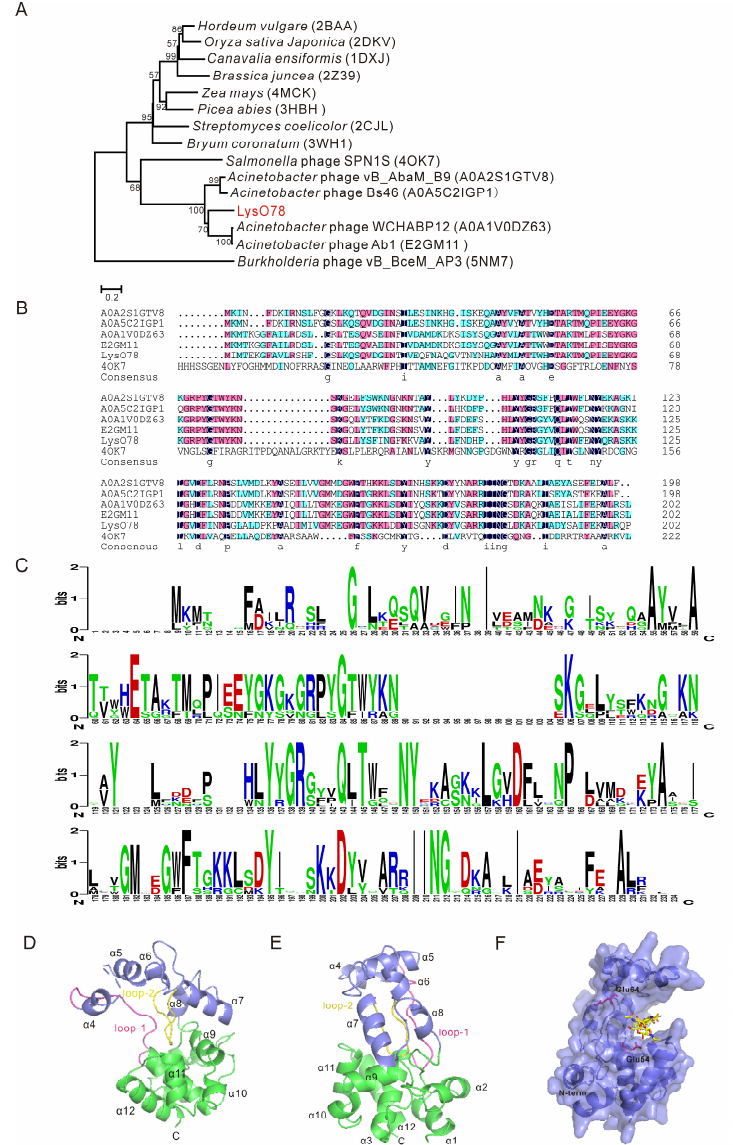
Figure 4. Bioinformatic analysis of the endolysin LysO78. ( A ) Phylogenetic analysis of LysO78 with other phage endolysins and plant chitinases. The proteins used for the phylogenetic analysis were chosen through sequence and structure similarity. The most similar proteins in terms of sequence are the Acinetobacter phages endolysins, shown by their UniPortKB identifier (ID). ( B ) Amino-acid sequences alignment of LysO78 with Acinetobacter bacteriophage endolysins and Salmonella typhimurium phage SPN1S endolysin (PDB ID: 4OK7). The amino acid homology equal to 100% are colored in deep blue; the amino acid homology equal or overtop to 75% are colored in magenta; the amino acid homology equal or overtop to 50% are colored in cyan. ( C ) Sequence conservation analysis of LysO78 and other phage endolysins. The basic amino acids (K, R, H) are colored in blue; the acidic amino acids (D, E) are colored in red; the nonpolar hydrophobic amino acids (A, V, L, I, P, W, F, M) are colored in black; the polar uncharged amino acids (C, G, Q, N, S, Y, T) are colored in green. ( D , E ) The overall structure of endolysin LysO78 is shown in two different orientations. The left panel presents a side view, while the front view is shown in the right panel. The large domain and small domain are colored in green and slate, while the two groove loops are shown in magenta and yellow. ( F ) The structure of endolysin LysO78 complexed with a pseudosubstrate. The overall structure is shown in cartoon and surface representations colored in blue and slate. The catalytic residues, E54 and E64, are shown in stick representation and colored in magenta, and the (GlcNAc) 4 molecule is shown in stick representation and colored in